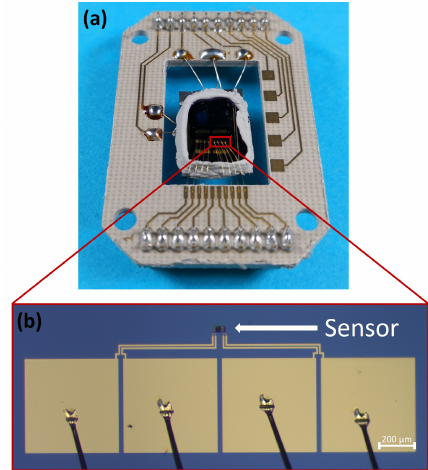
Figure 1. ( a ) Evaluation board with soldered heater and thermocouple and wire bonded gas sensor stack. ( b ) Wire bonded gas sensors with electrode